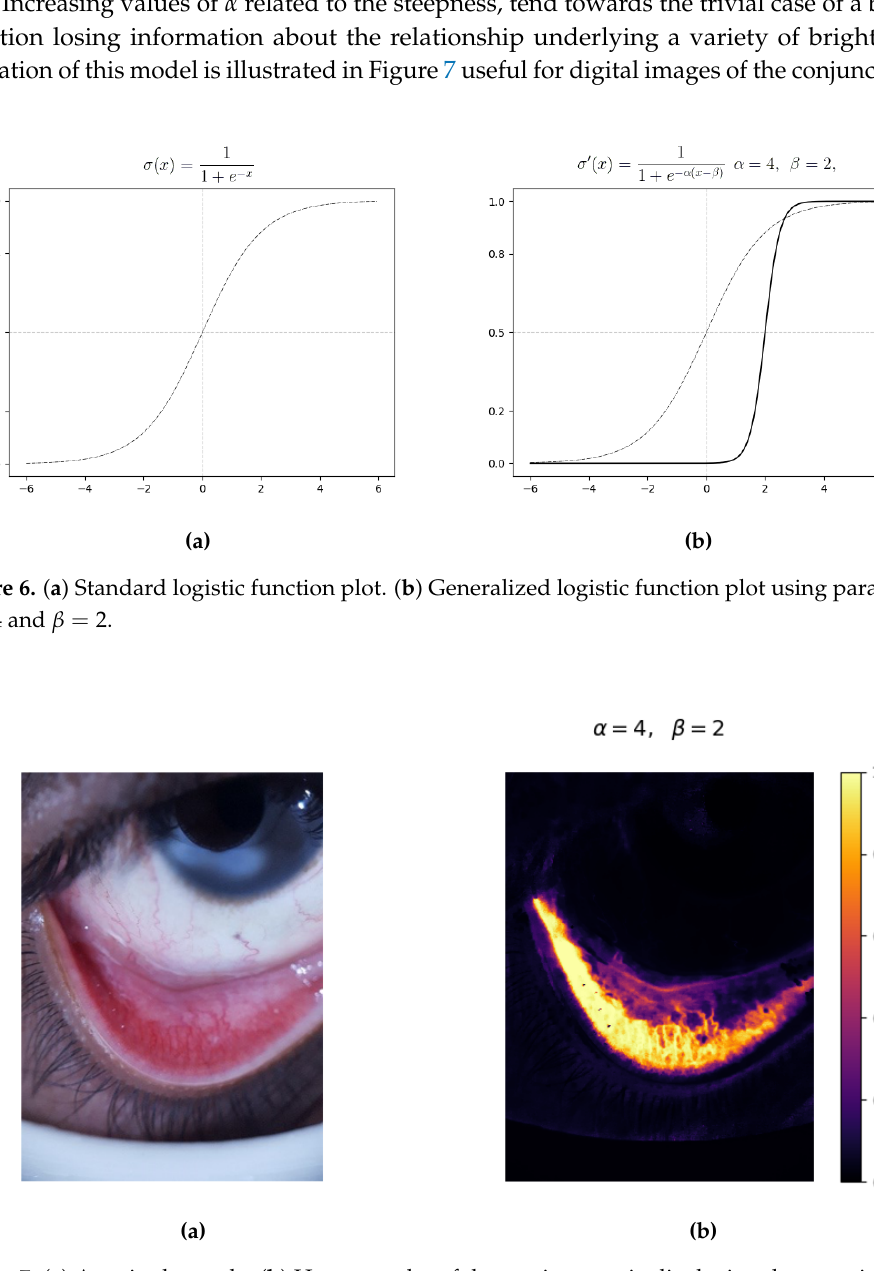
Figure 7. ( a ) Acquired sample. ( b ) Heatmap plot of the scoring matrix displaying the magnitudes of the coefficients computed by applying the generalized sigmoid function on the acquired